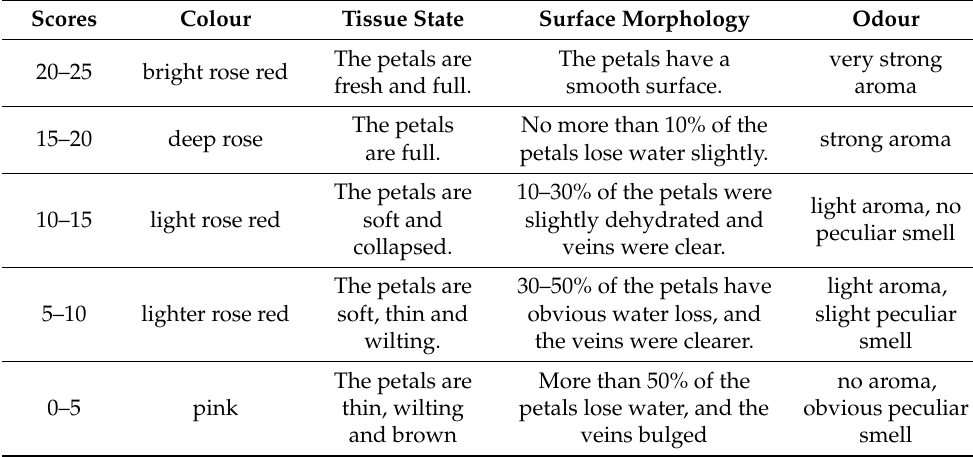
The petals are thin, wilting and brown